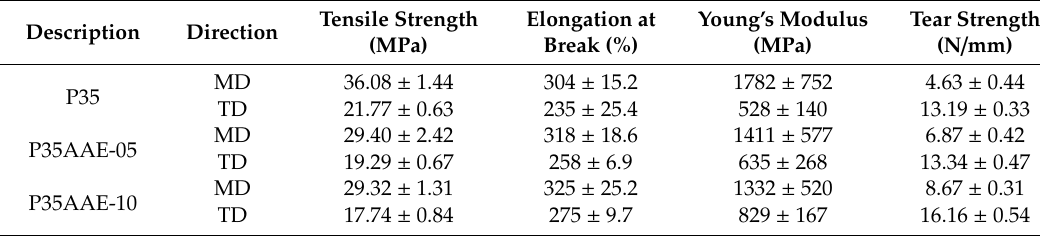
Figure 5. Mechanical properties of the neat PLA / PBAT and plasticized PLA / PBAT blown film. Table 5. Mechanical properties and tear strength of the neat PLA / PBAT and plasticized PLA / PBAT blown film.